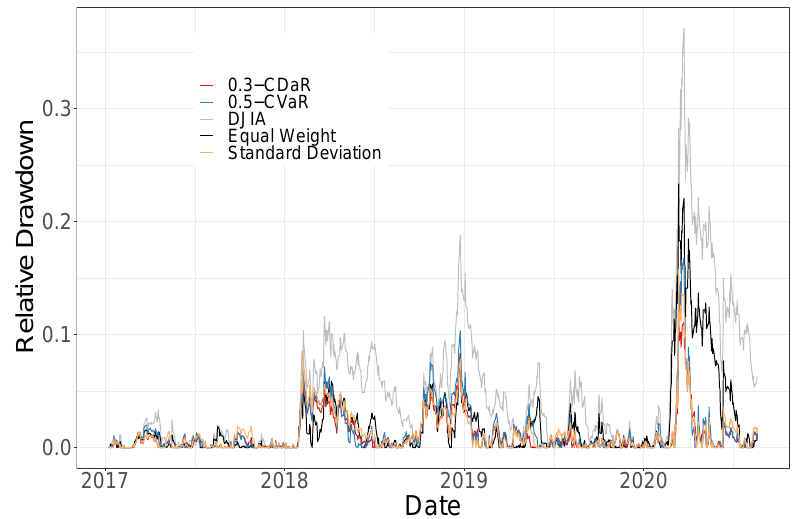
Figure 2. Relative drawdown: this figure plots the relative drawdown paths of optimal portfolios with different risk measures, the DJIA index and the equally weighted portfolio. The risk measures include 0-CDaR, 0.5-CVaR and standard